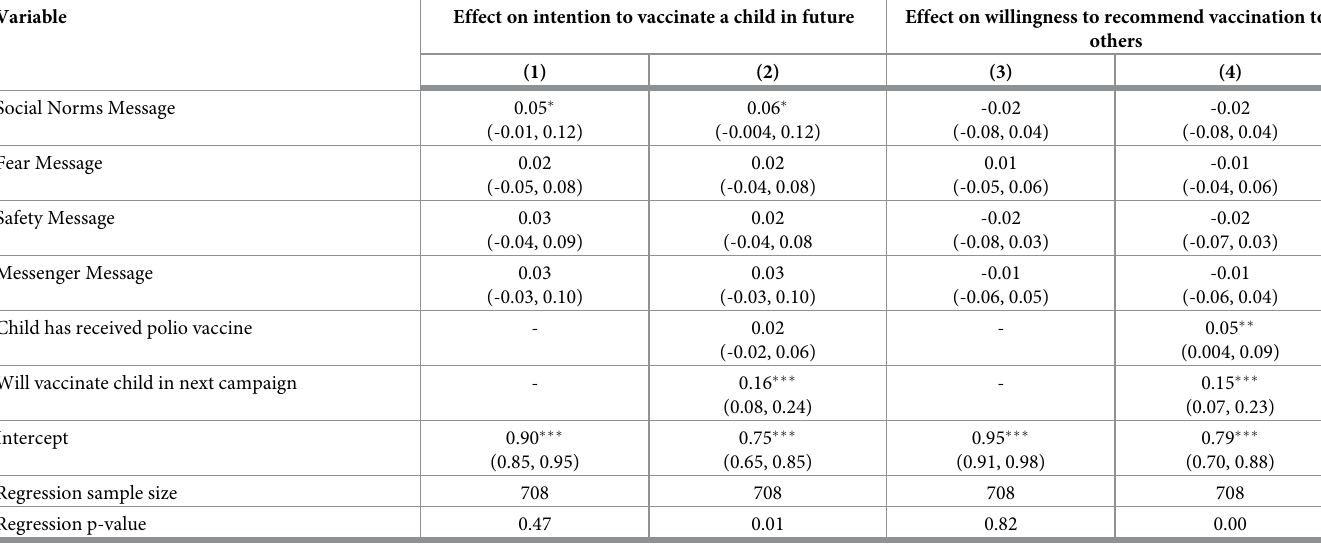
Table 5. Efficiency of the nudges with different message frames on the full sample of 708